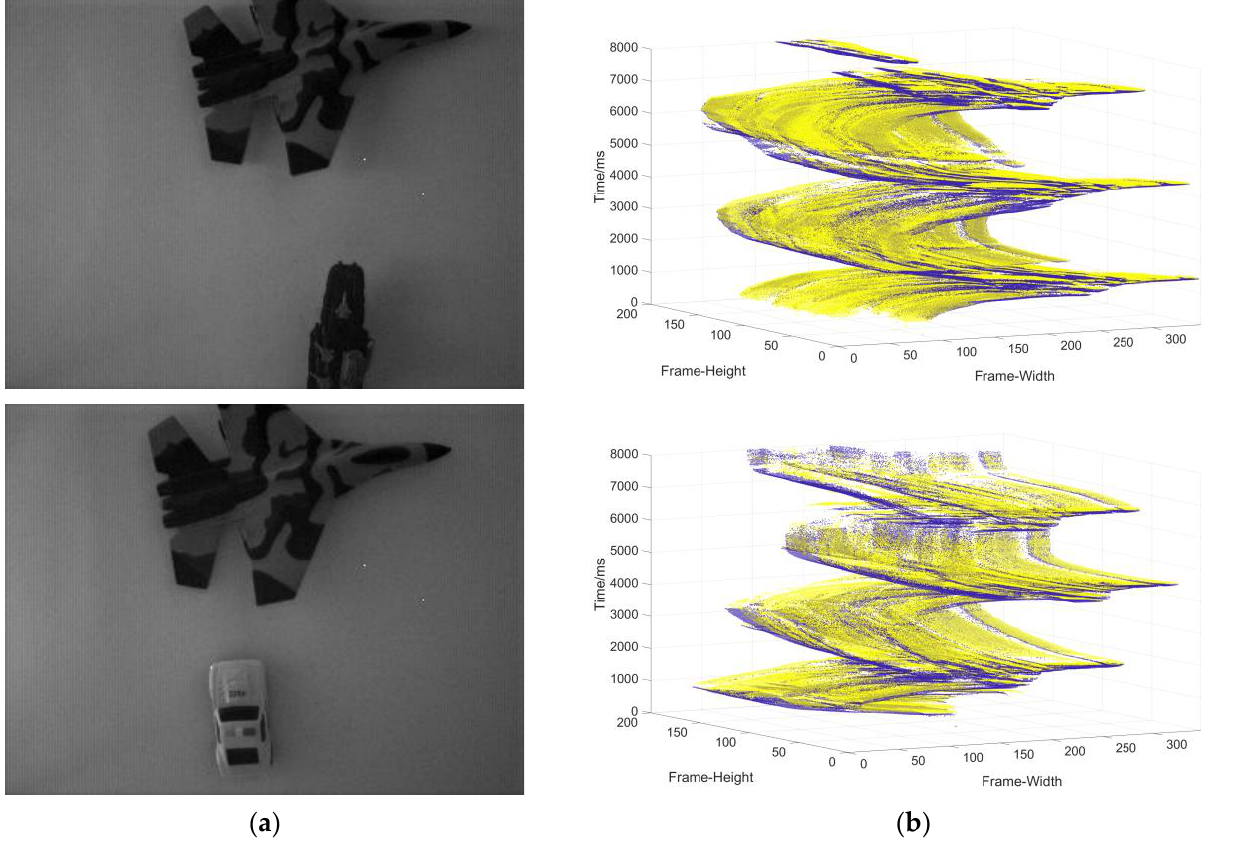
Figure 10. ( a ) The object used to generate the event stream; ( b ) three-dimensional spatiotemporal event stream generated by the object in ( a ).